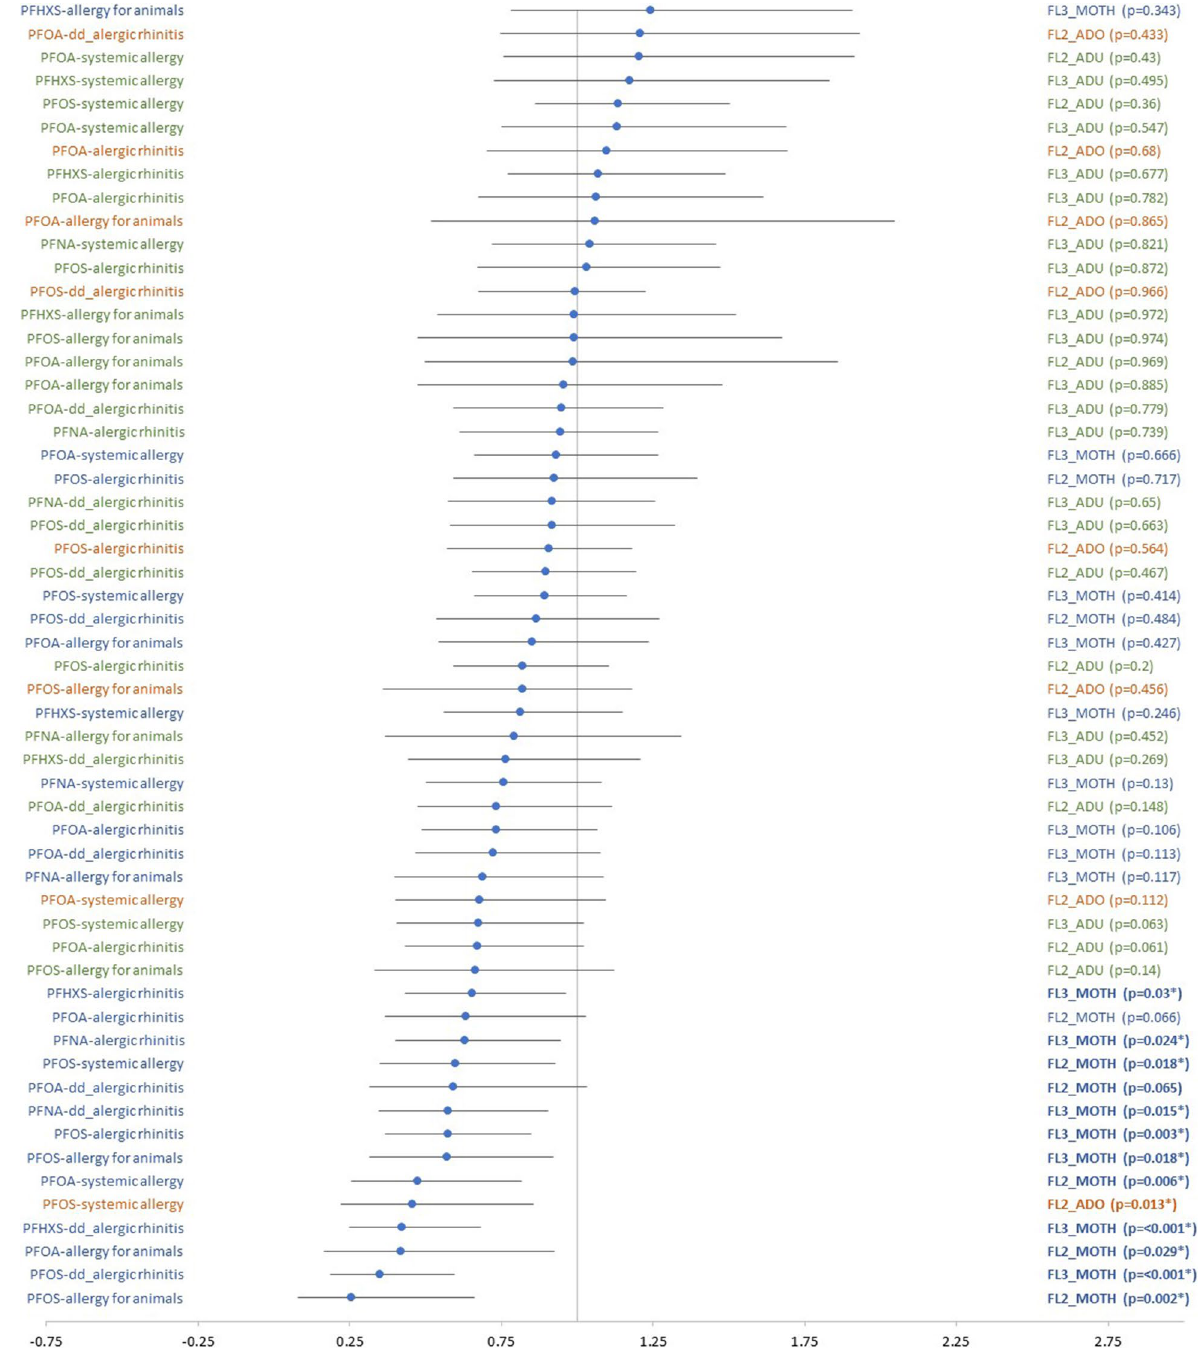
Fig. 3 Forest plot of the odds ratios (ORs) of the allergy outcomes: allergic rhinitis, allergy to animals and systemic allergy in relation to the measured PFAS in the different FLEHS studies (with FL2 FLEHS-2, FL3 FLEHS-3, ADO adolescents, ADU adults, MOTH mothers). The OR (95% confidence interval) is expressed for an interquartile increase in exposure . Confounders and covariates that were included at the start of the stepwise multiple regressions are mentioned in Additional file 1: Tables S2, S3, S4, S5 and